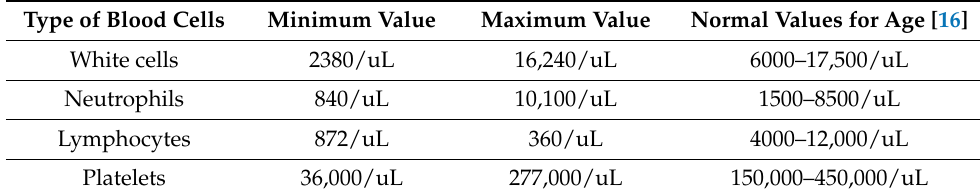
Table 2. Minimum and maximum values of our patient’s blood cells registered during the hospital- ization, compared to normal values for